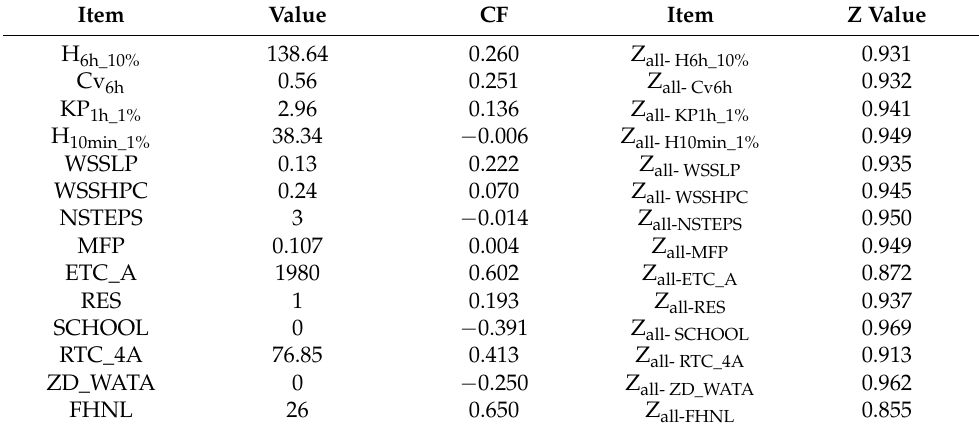
Table 11. Z Value Results for One